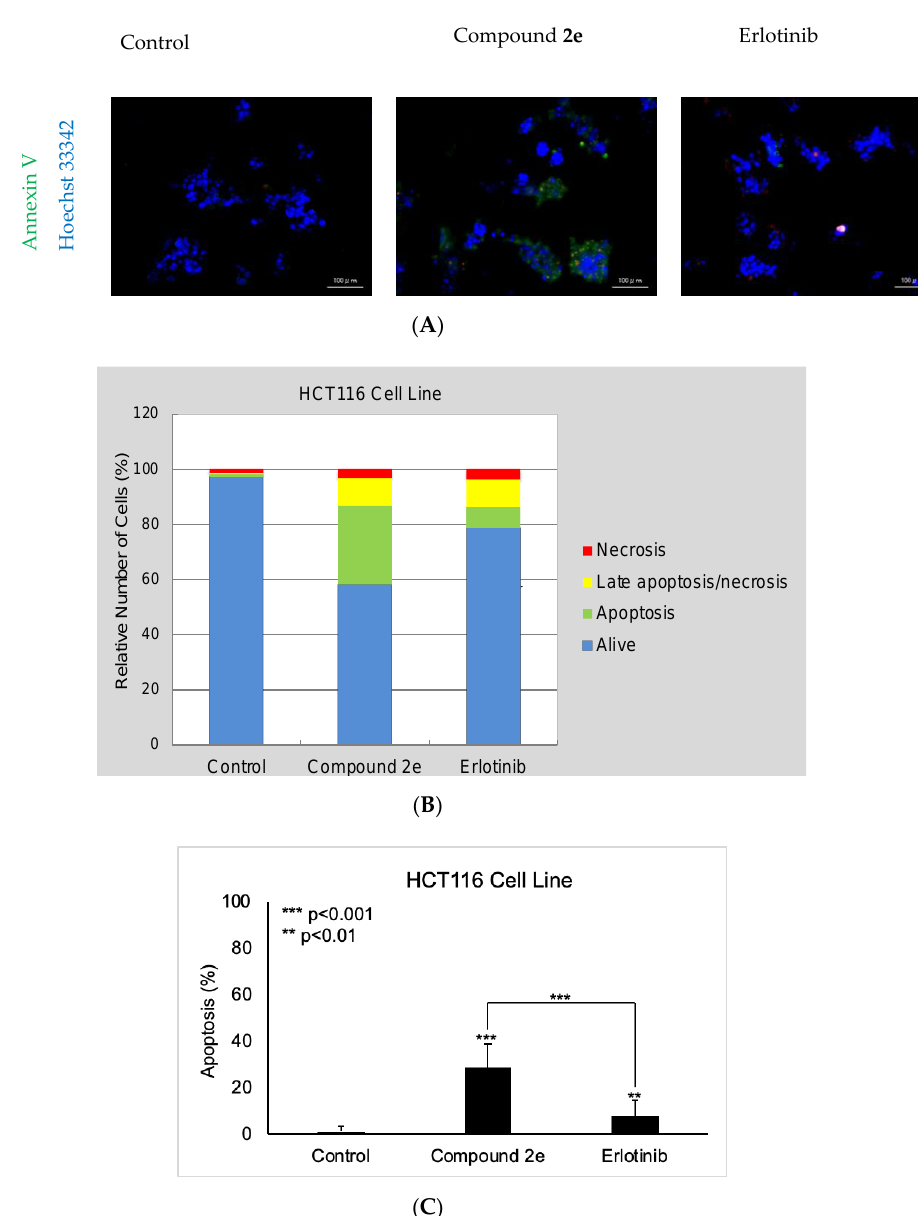
Figure 1. The apoptosis-inducing e ff ects of compound 2e and erlotinib on the HCT116 cell line. Alteration in HCT116 cells at 10 µ M concentration of control, compound 2e , and erlotinib ( A ) for 12 h. ( B ) A total of approximately 100 stained cells were selected randomly in each experiment of ( A ) and were classified into 4 types: “alive” (blue), “apoptosis” (green), “necrosis or late apoptosis” (both green and red), and “necrosis” (red). ( C ) Quantification of the e ff ect of compound 2e and erlotinib on apoptosis. Data from three independent experiments are shown as means ± standard deviations and p values were determined using Student’s